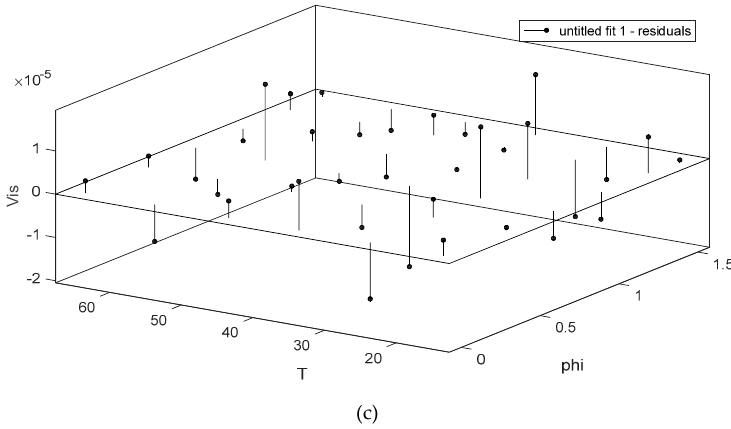
Figure 8. Contour graphs (3D) describing the model’s ( a to c ) viscosity (Vis) distribution. (T (temperature) and phi (Volumetric Concentration (%)).